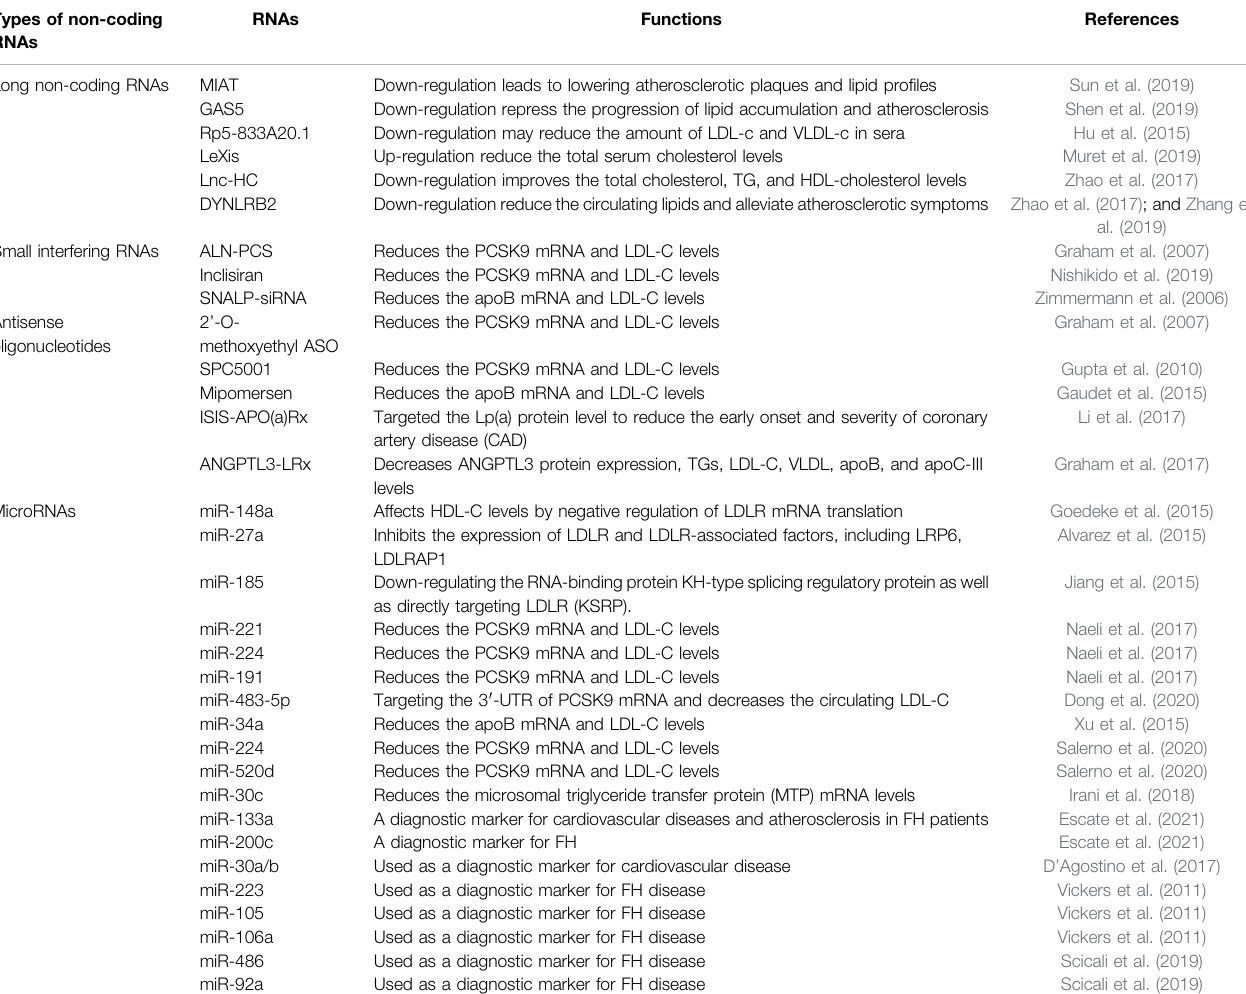
TABLE 1 | Application of different non-coding RNAs in